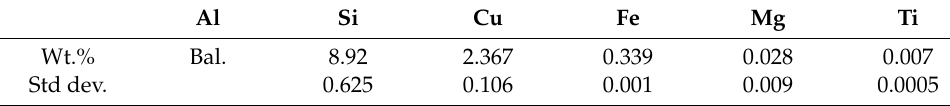
Table 1. Chemical composition of the utilized powder, as measured by ICP.